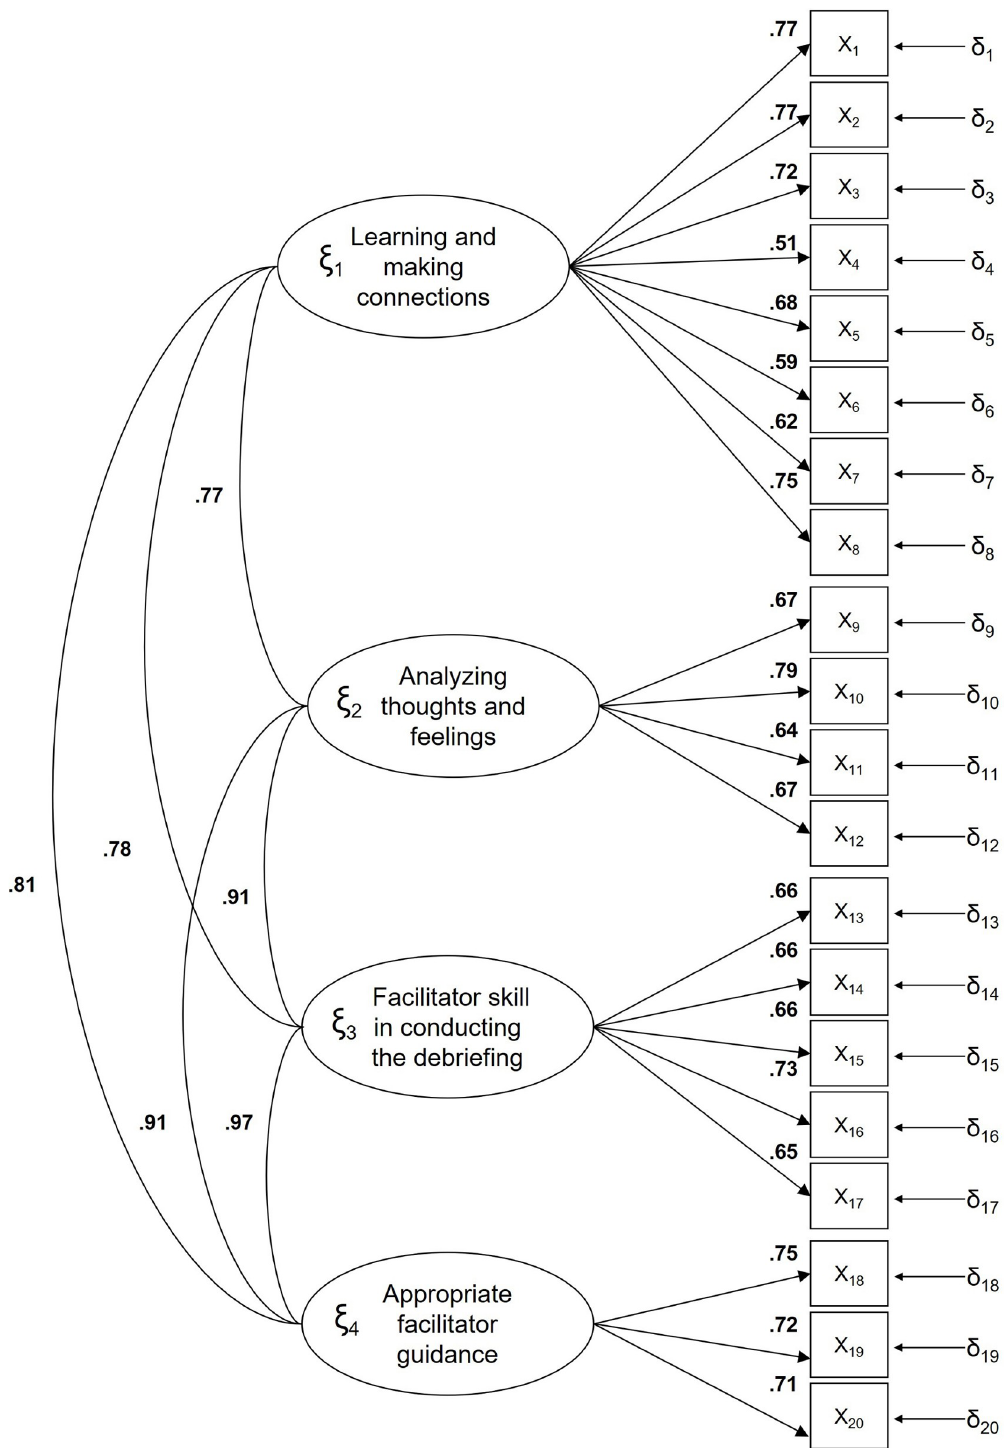
Fig 2. Standardized model parameters for the Debriefing Experience Scale for importance of simulation.